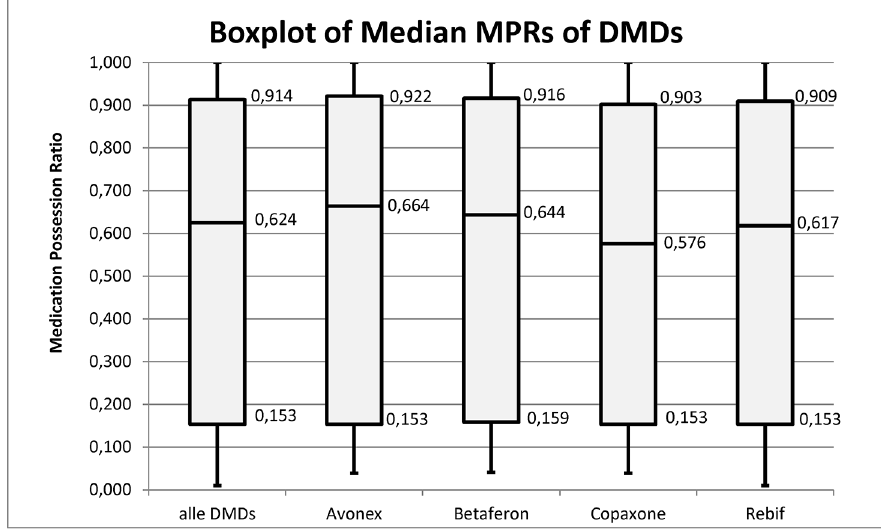
Fig 4. Median Medication Possession Ratios of the four DMD